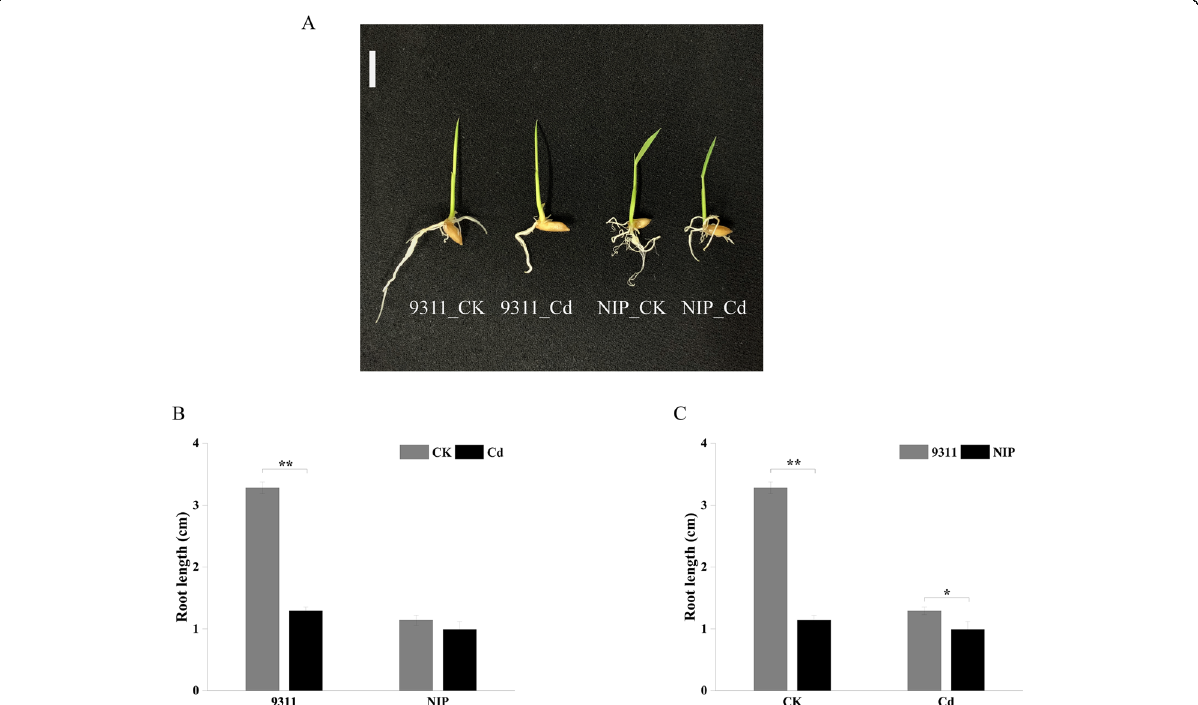
Fig. 1 Phenotypes of cv. 9311 and cv. NIP under CK (control) and Cd (cadmium)groups. ( A ) The 3-day-old seedlings of cv. 9311 and cv. NIP under control condition and Cd stress conditions. ( B ) and ( C ) Comparison of root length, in 3-day-old seedlings of cv. 9311 and cv. NIP under under control condition and Cd stress conditions, respectively. Data are presented as means± SE. n = 15. Statistical analysis was conducted using the Student ’ s t-test. *, P -value < 0.05; **, P -value < 0.01; ***, P value < 0.001. scale bar = 1